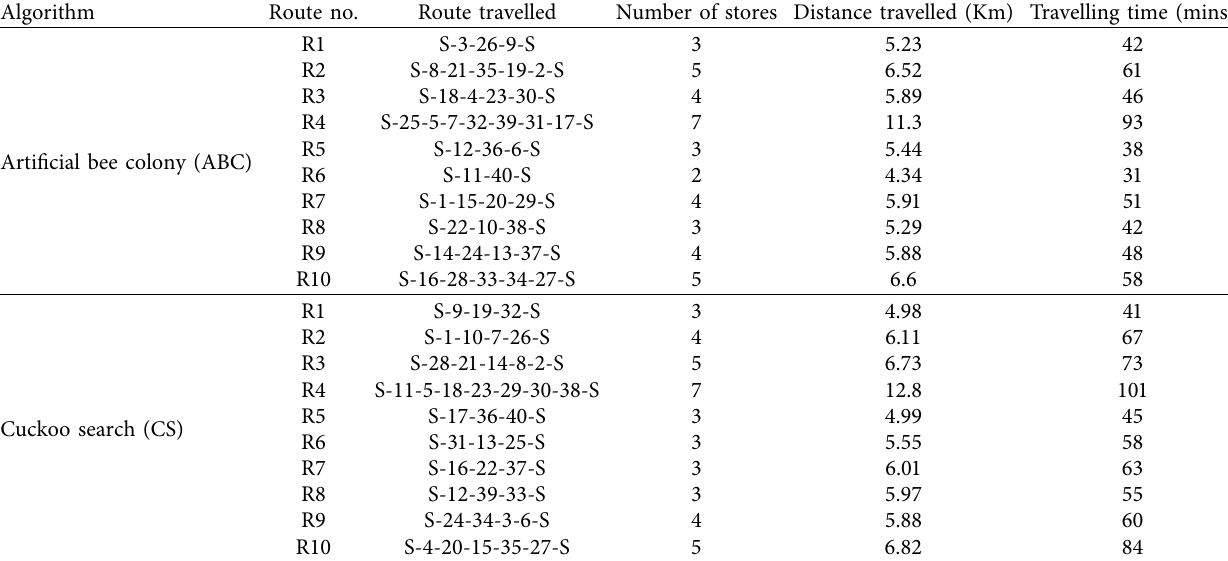
Table 2: 40 delivery locations with 10 delivery vehicles.